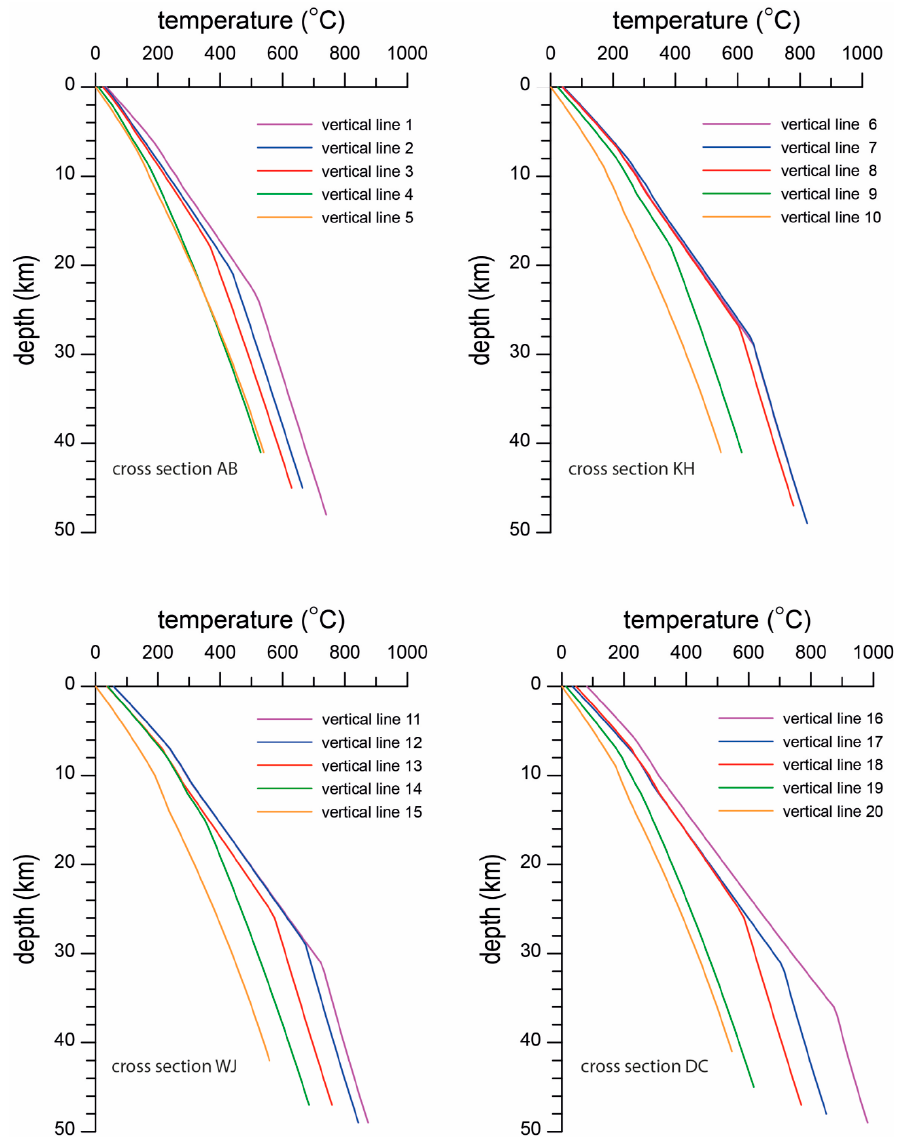
Figure 7. Calculated geotherms for the 20 pseudo-wells of Figure 5. Each graph contains the geotherms relative to the respective cross-sections AB, KH, WJ, and DC shown in Figure 8.